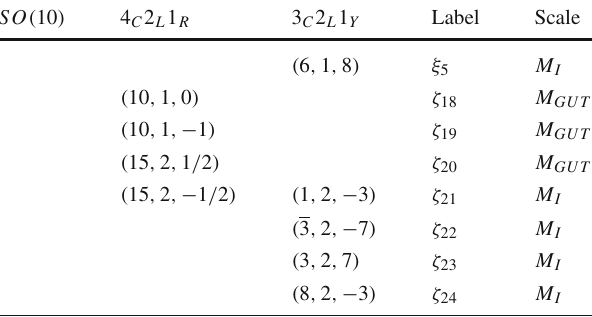
Table 11 Decomposition of the scalar representations in an SO ( 10